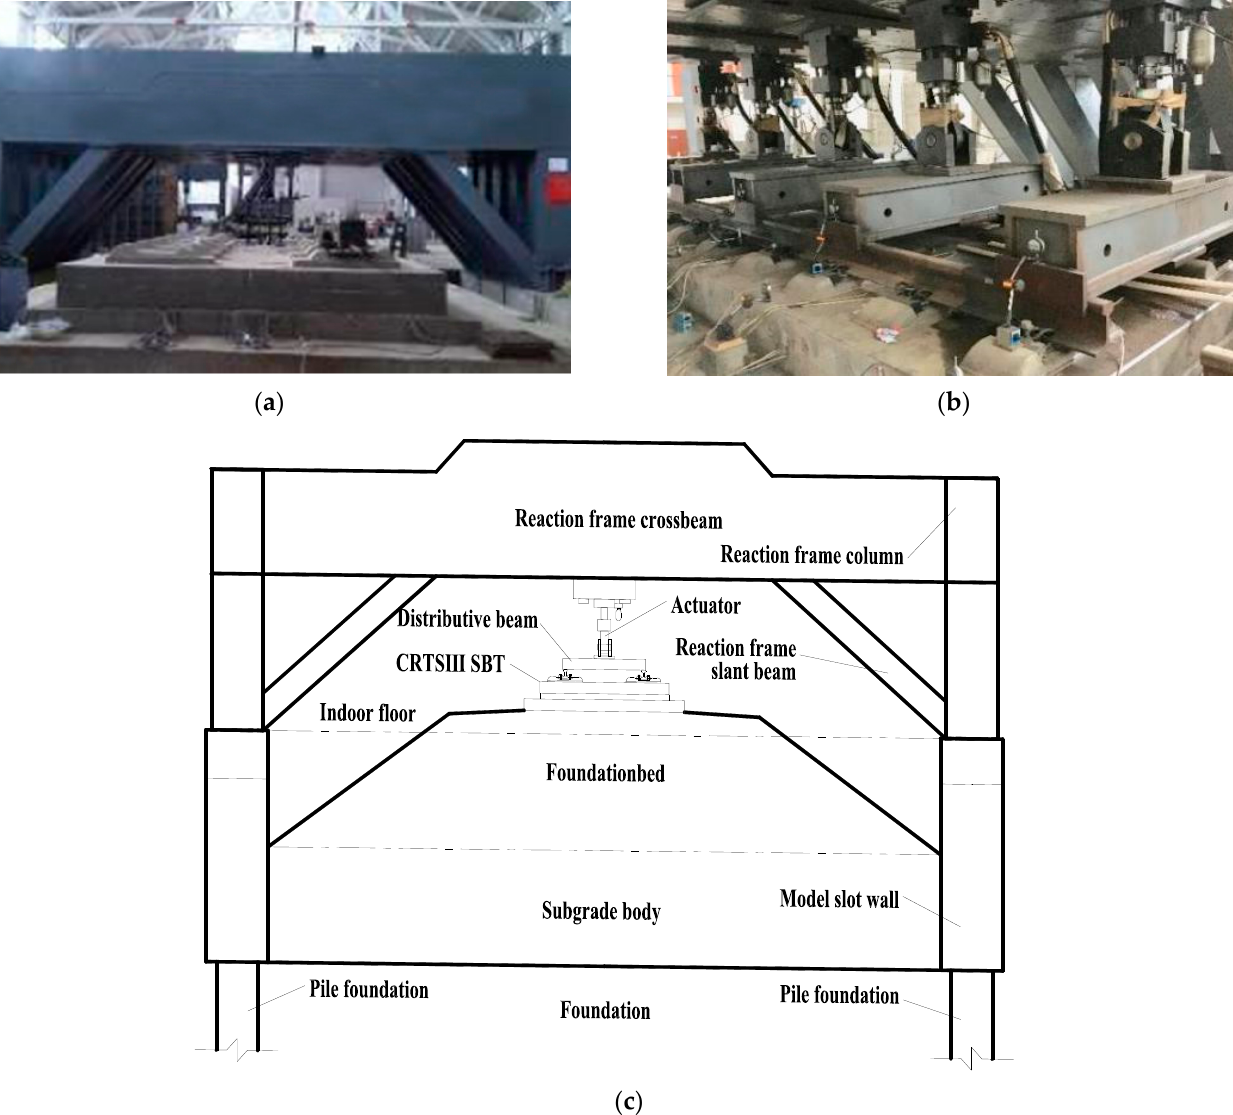
Figure 5. Track–subgrade dynamic model test system: ( a ) model entity diagram; ( b ) model loading diagram; ( c ) cross-sectional view of the model.